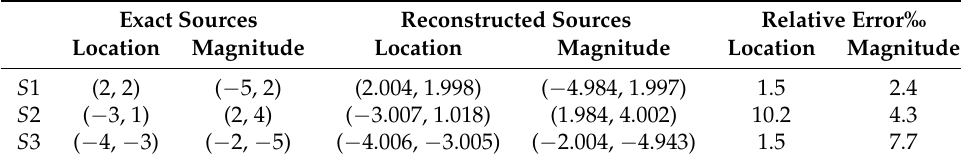
Table 6. Reconstruction of the location and magnitude of three point sources.